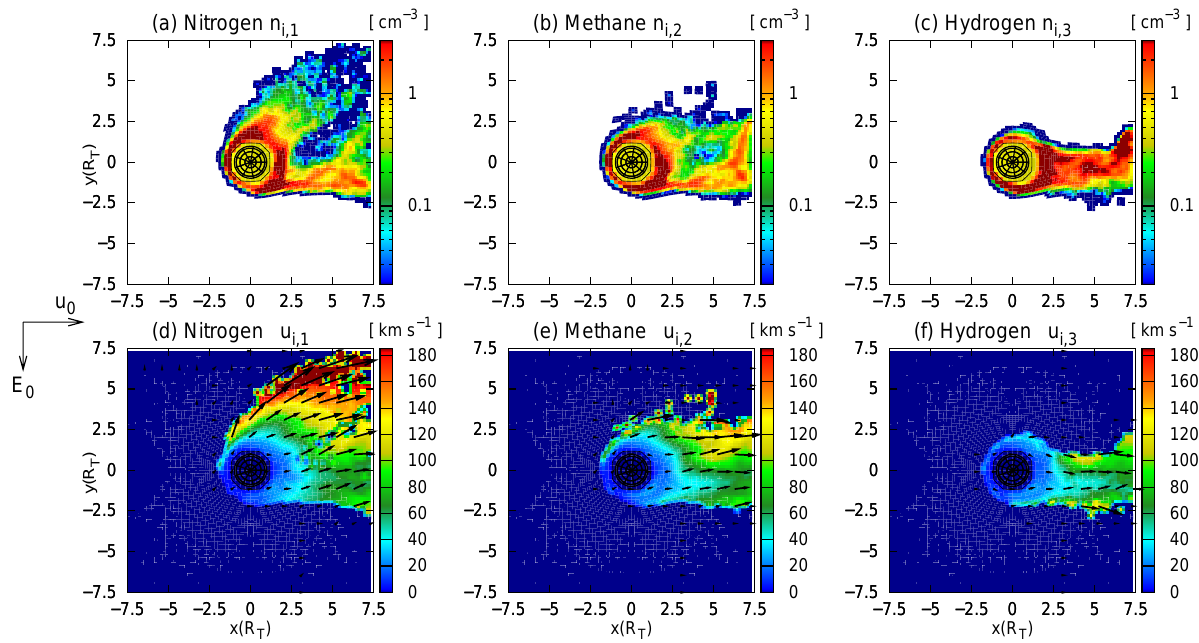
Fig. 13. Run #5 : Influence of a tangential discontinuity on Titan’s plasma tail. The discontinuity denotes a reversal of the magnetic field direction from B ∝ − e z to B ∝ + e z . The figure shows the ionospheric plasma parameters about 200 time steps after the discontinuity has left the simulation box. In this time, the undisturbed magnetospheric plasma would travel a distance of 2 . 3 R T , i.e. the discontinuity would be located at x = 9 . 8 R T .